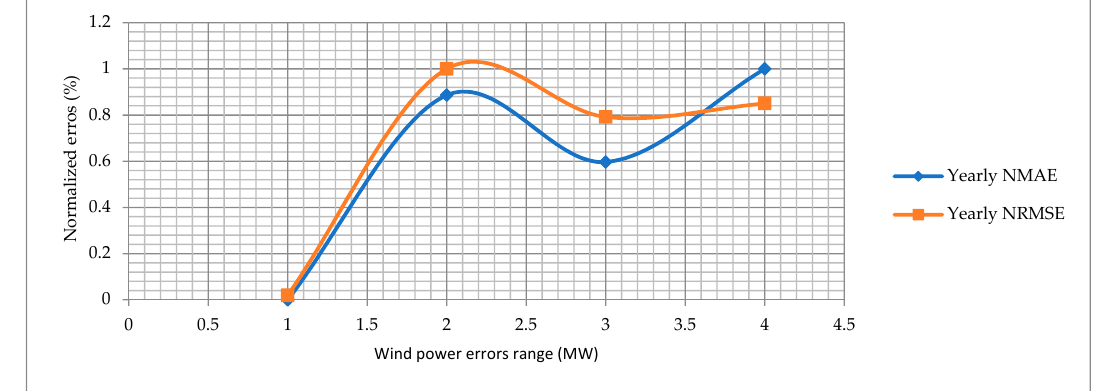
Figure 20. Normalized errors for yearly wind power forecasting.